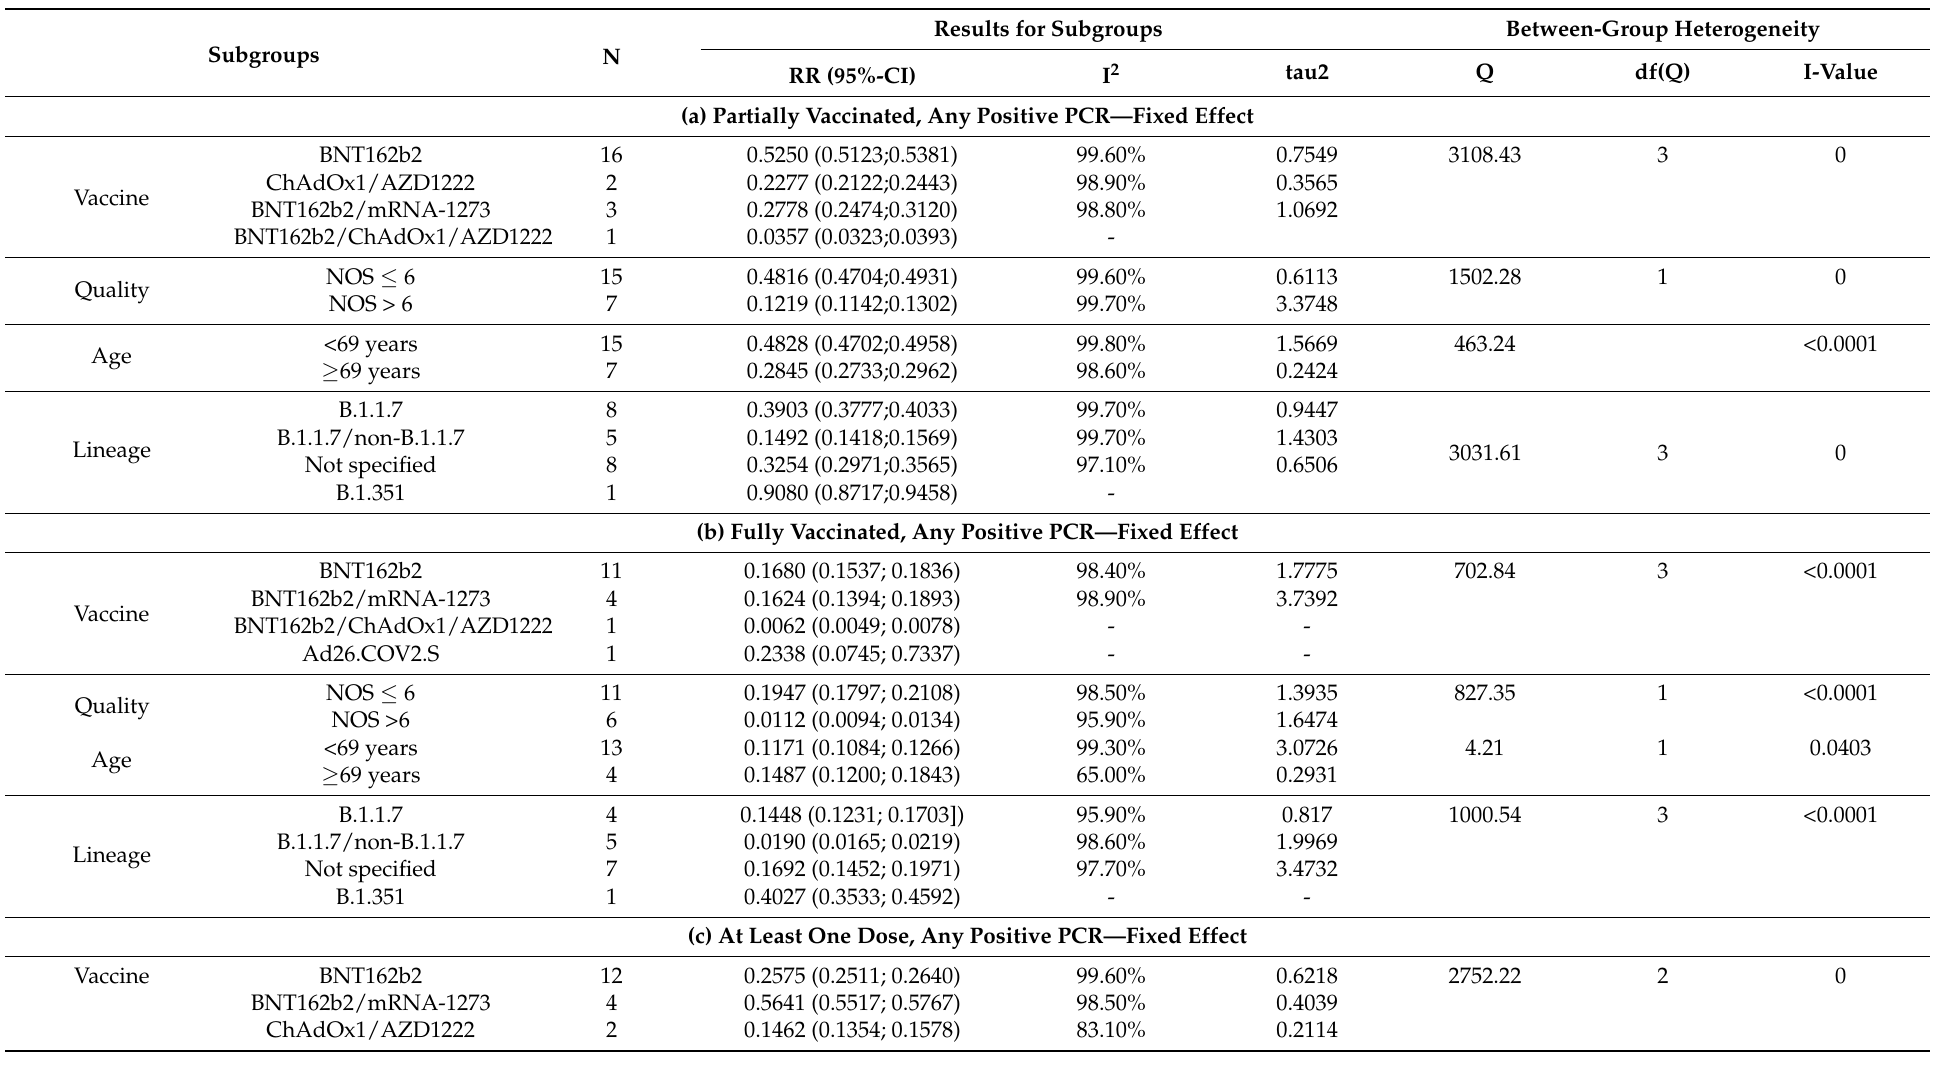
Table 2. Subgroup meta-analysis, any SARS-CoV-2 protocol. Fixed-effect